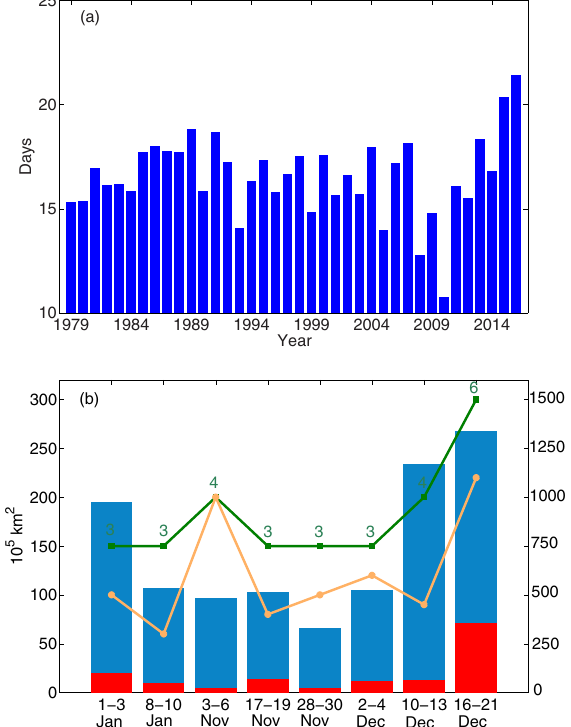
Figure 1. (a) The variation of DHD NH from 1979 to 2016 and (b) the parameters of the main haze processes in China in 2016: haze (blue bar) and severe haze (red bar) covered area (left y -axis), the maximum PM 2 . 5 concentration (yellow line, right y -axis, unit: µgm − 3 ) and the number of days lasted (green line and